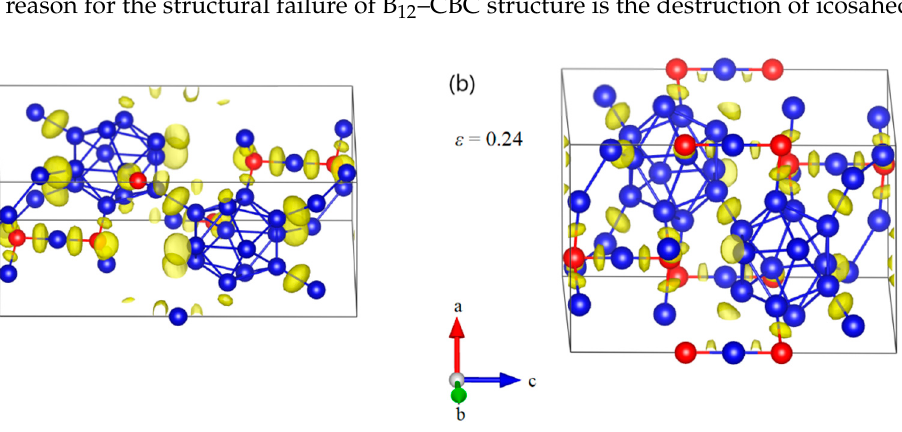
Figure 4. The stress-strain relationships for on B 12 –CBC, B 11 C P –CBC and B 10 C 2P –CC configurations under a axis uniaxial compression.